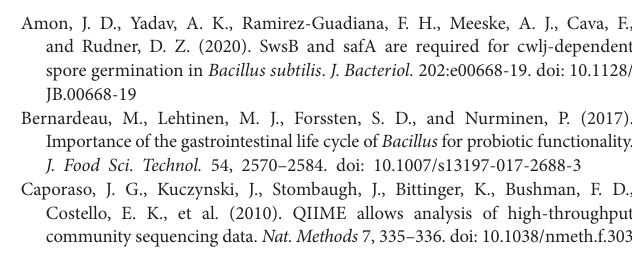
Supplementary Figure 1 | Phylogenetic tree based on the 16S ribosomal RNA sequences from 26 Bacillus strains. The tree was constructed using the